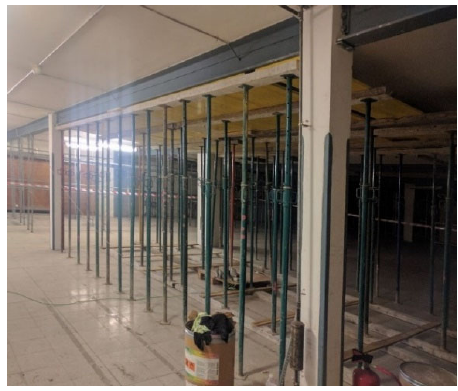
Figure 8. General view of the shoring and formwork on basement level ‐ 2 for safety reasons.